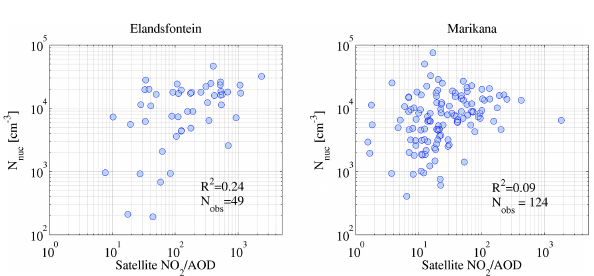
Figure 12. The comparison between the number concentration of nucleation mode particles and NO 2 /AOD calculated from the satel- lite data at Marikana and at Elandsfontein stations. The number con- centrations are 1h averages (13:00–14:00LT) representative of the satellite overpass time. It is noted that at Elandsfontein N nuc rep- resents particles with D p 10–30nm and at Marikana particles with D p < 30nm. N obs denotes the number of coincident